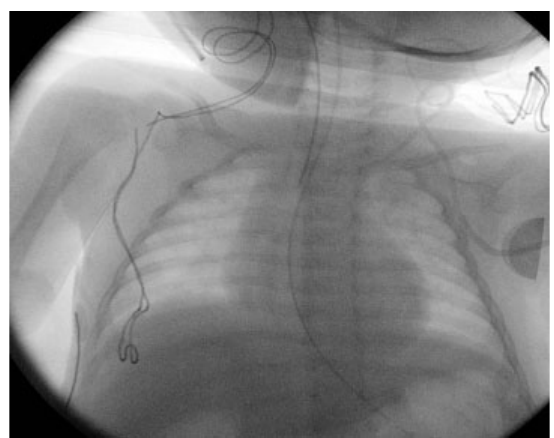
Fig. 1 Intraoperative X-ray image showing the tip of central venous catheter in left brachiocephalic